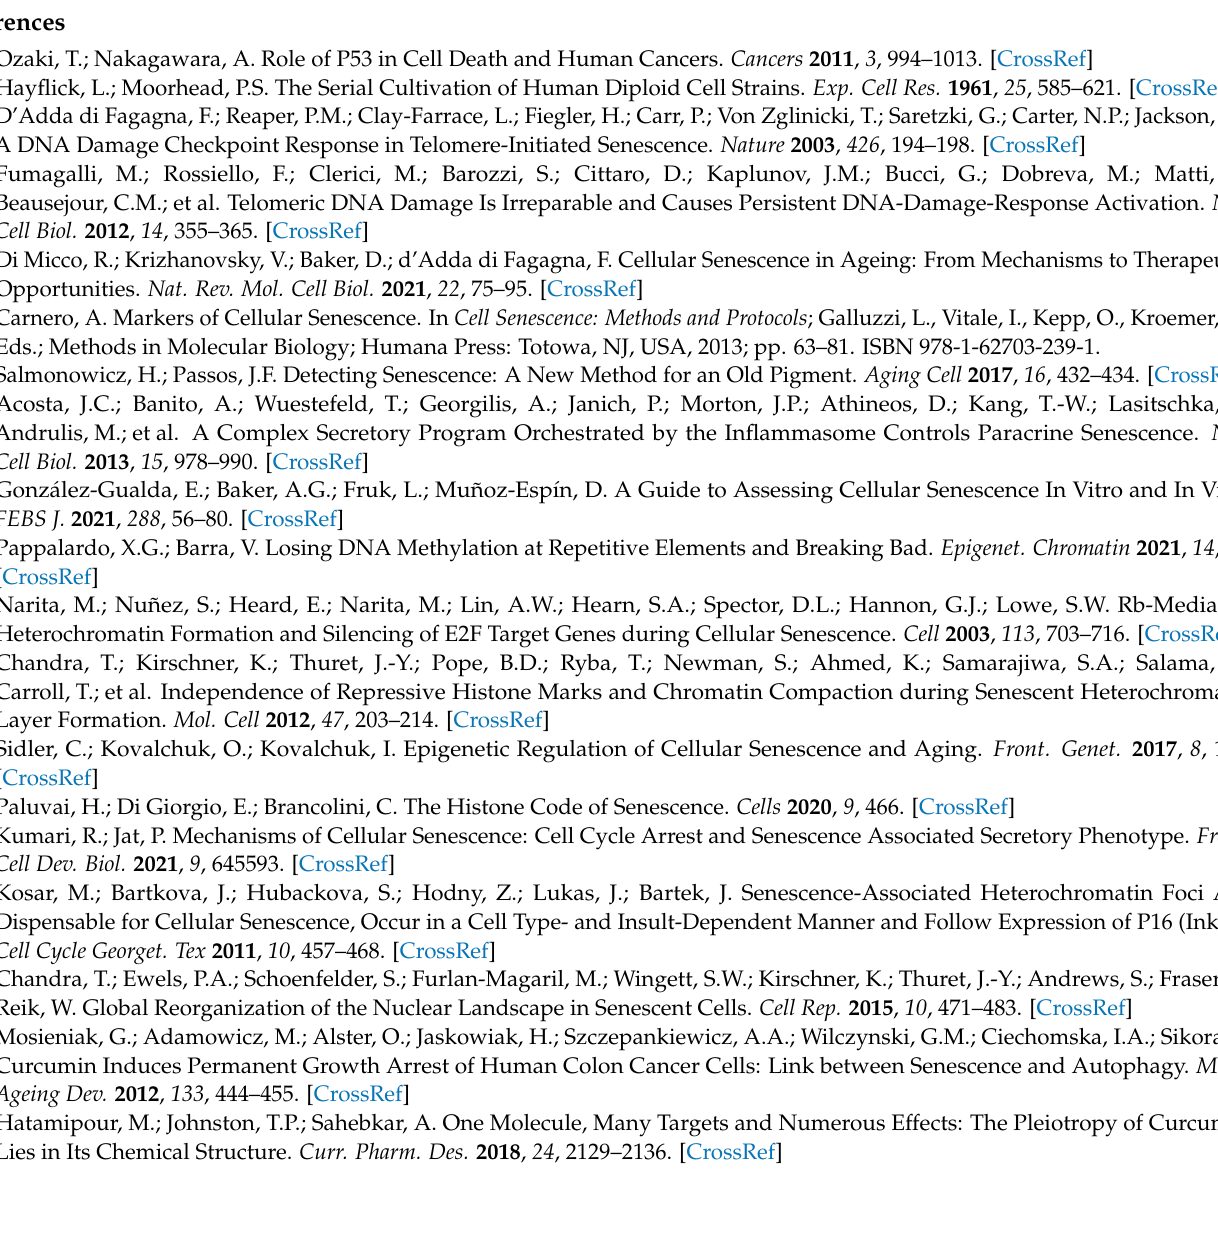
and Figure 4B; S.T. performed H3K9me3 immunofluorescence, SA- β -Gal staining, Western blotting, Trypan Blue staining, and clonogenic assay, and analyzed data; I.M.P. performed Western blotting, RT- qPCR, flow cytometry and SA- β -Gal staining; P.S.C. analyzed images of MPM2